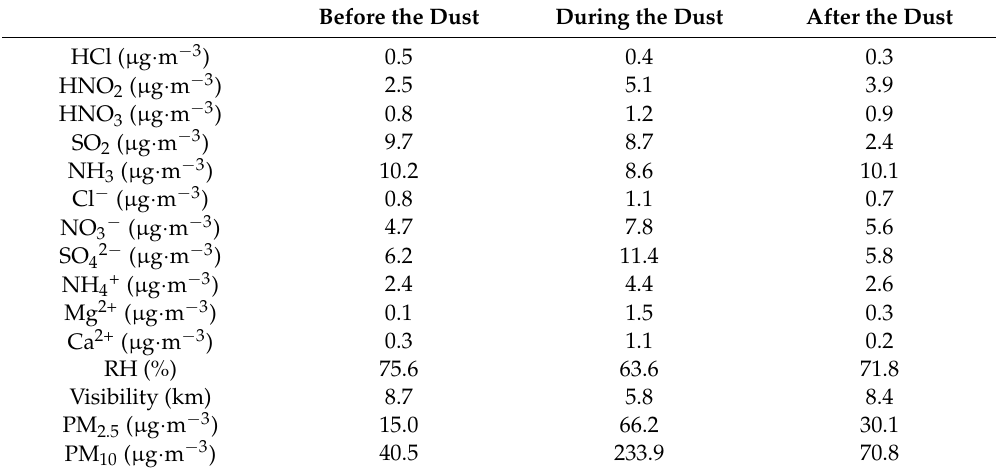
Table 1. Pollutant concentrations and meteorological elements during the dust and non-dust episodes. Before the Dust During the Dust After the